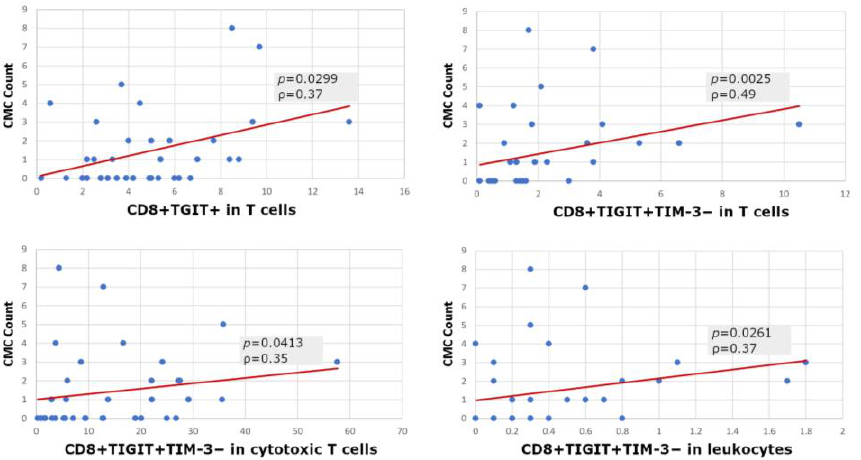
Figure 7. Correlations between baseline CMC counts and certain subpopulations of cytotoxic T cells (Spearman rank